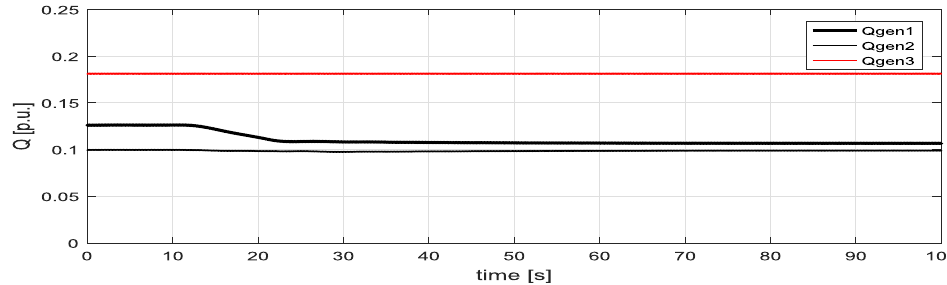
Figure 18. Time evolution of the reactive powers (Qgen) of the three